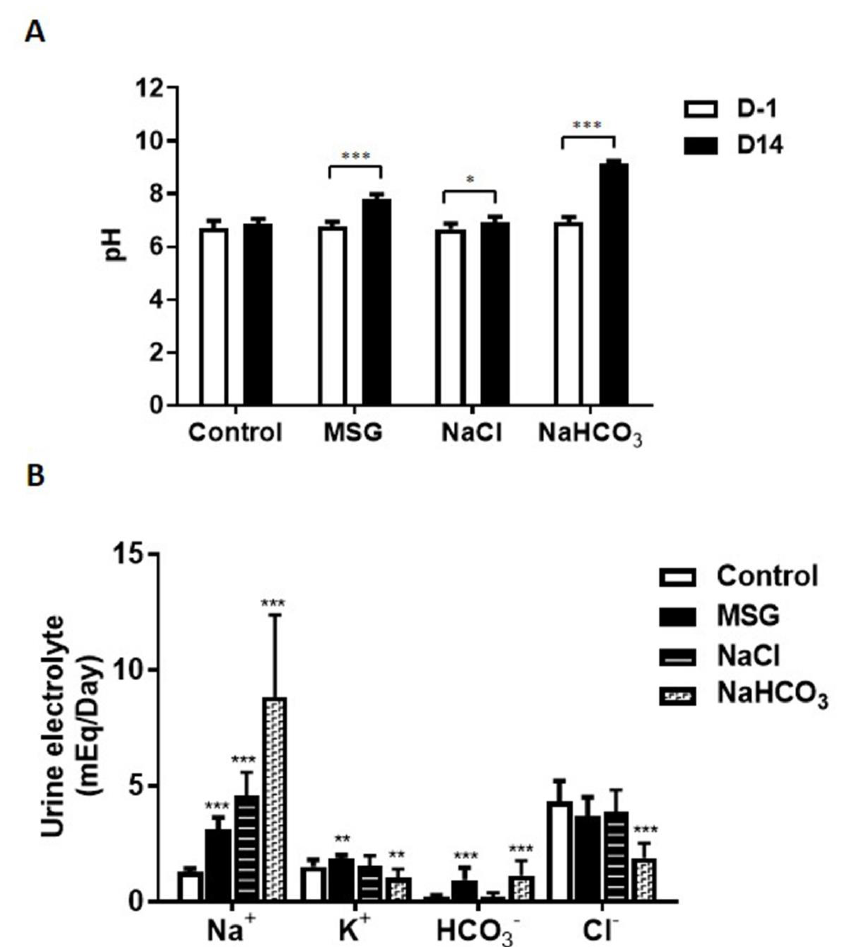
Figure 2. Urine pH ( A ) and electrolytes ( B ) after treatment in male Wistar rats supplemented with 1 g% MSG, 0.34 g% NaCl and 2.4 g% NaHCO 3 ( n = 10 per group). Data are shown as mean ± SEM and p -values calculated by Student’s t-test (* p < 0.05, ** p < 0.01, *** p < 0.001).